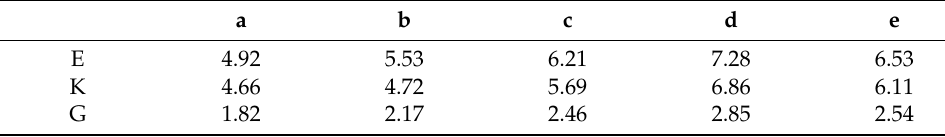
Table 2. Mechanical properties parameters